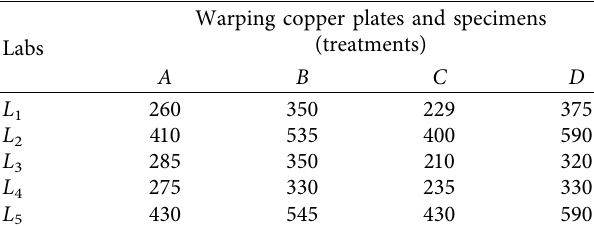
Figure 3: Tird bipartite graph. Table 1: Labs and warping copper plates and